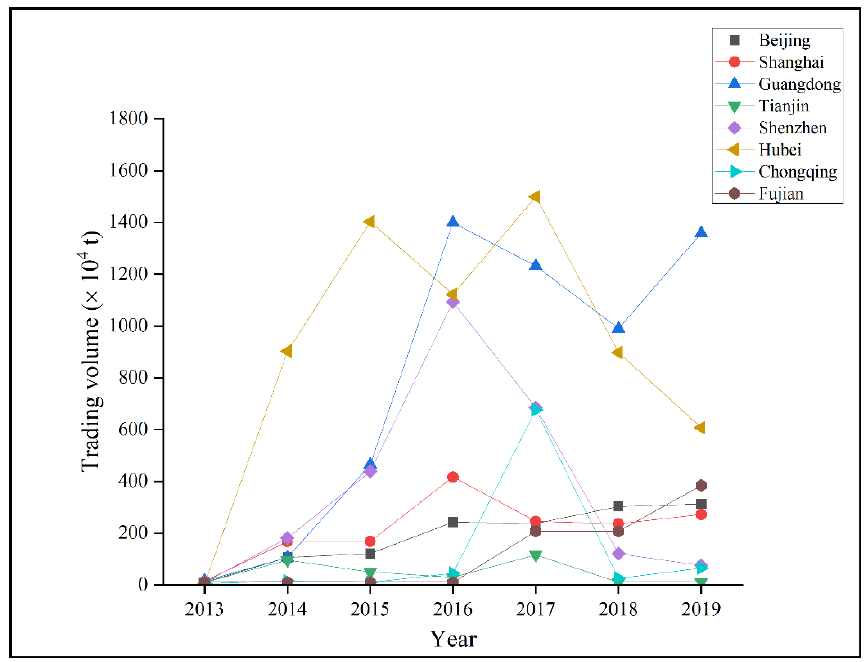
Figure 3. Volumes of carbon emission quota trading in pilot zones (2013–2019).